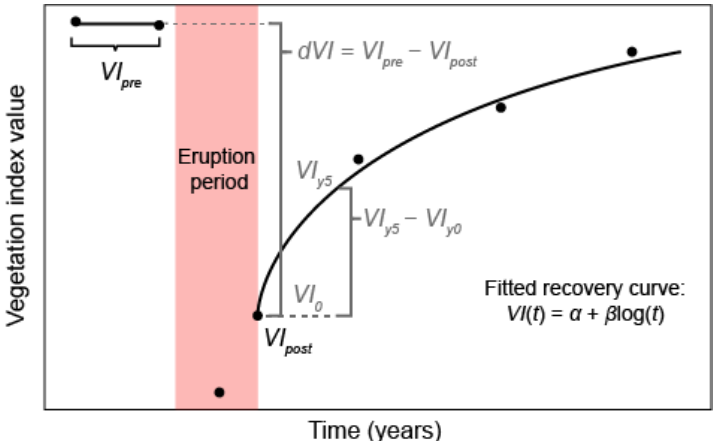
Figure 3. Schematic illustration of a pixel’s time-series trajectory, its associated fitted linear-log curve, and variables derived for Equations (4) – (6). The red column indicates the eruption period.